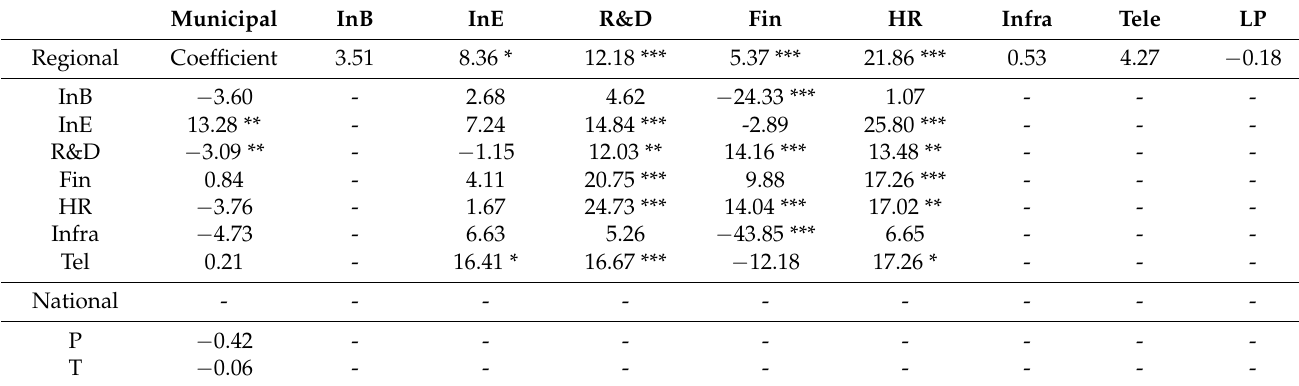
Table 6. The multilevel analysis results of collaborative